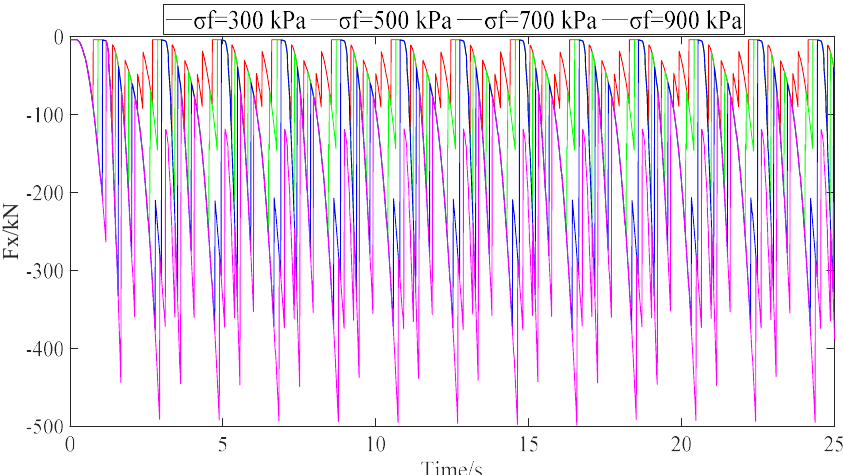
Figure 19. Time history curves of total ice force under different bending strength ( σ f ).